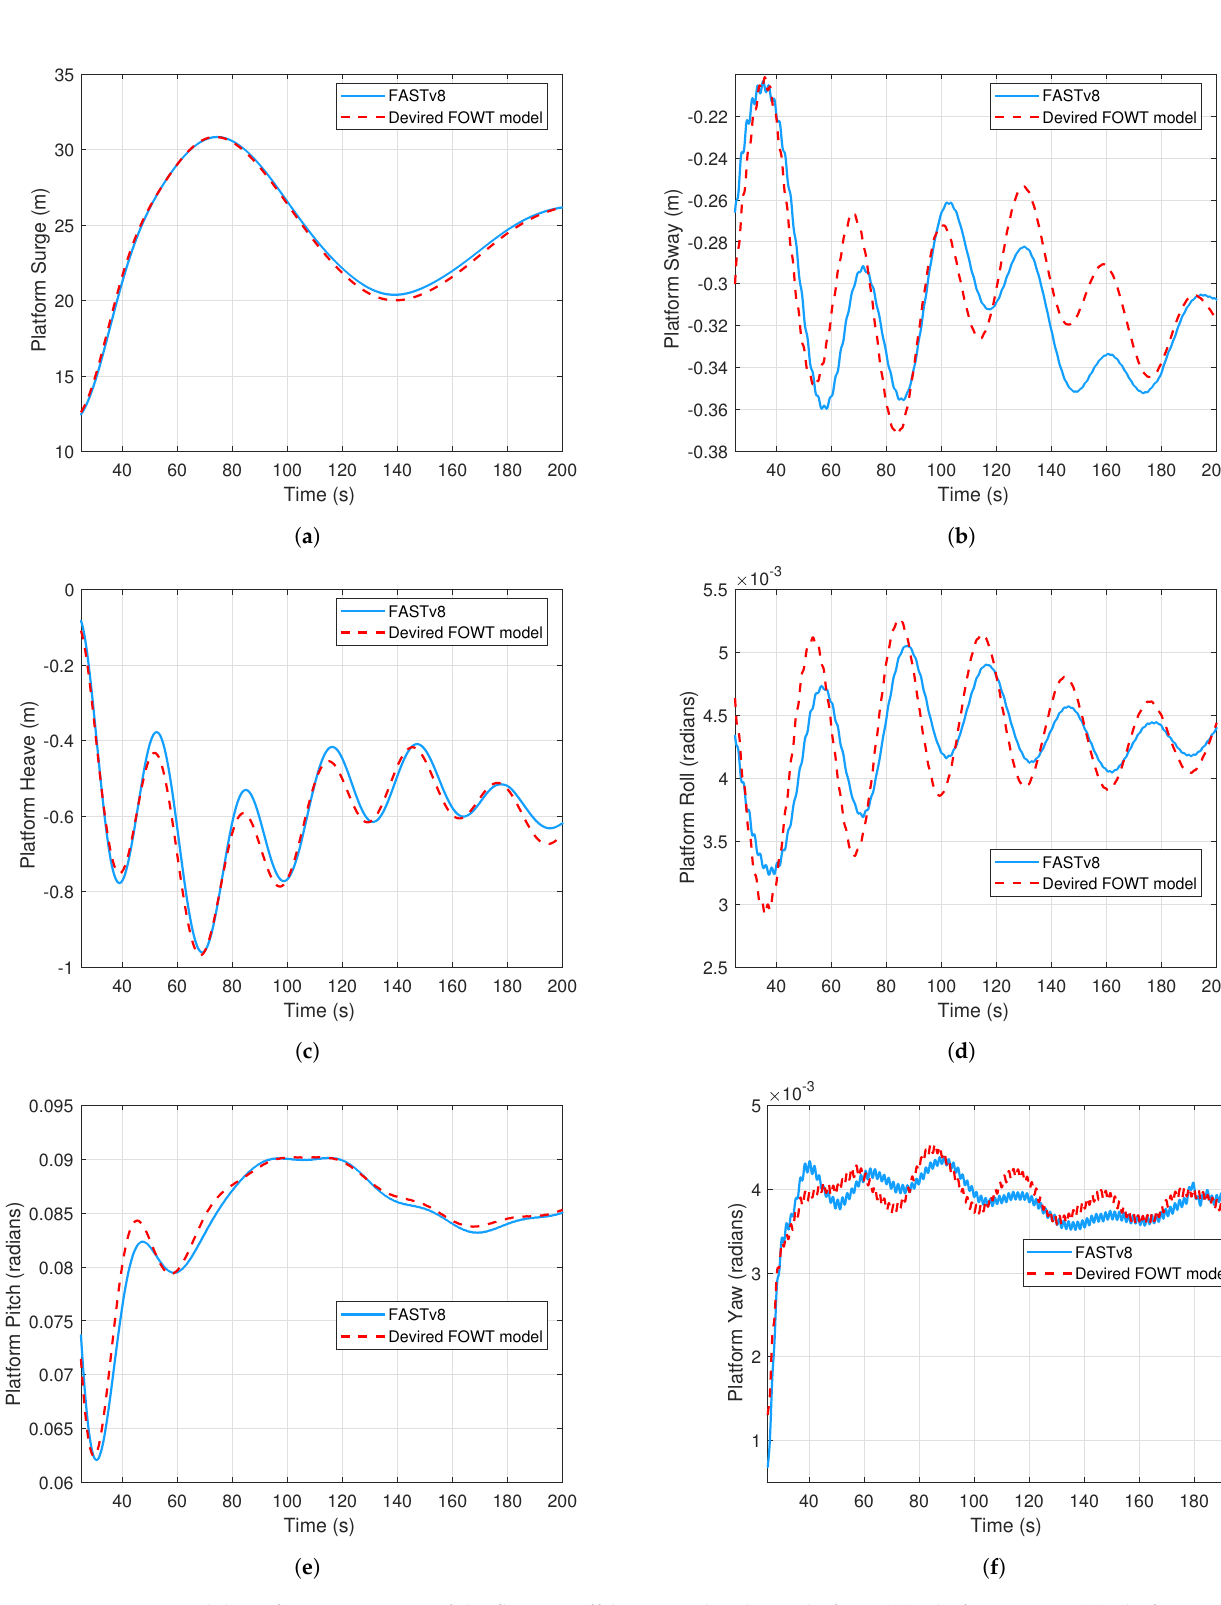
Figure A1. Model verification: motion of the floating offshore wind turbine platform. ( a ) Platform surge; ( b ) Platform sway; ( c ) Platform heave; ( d ) Platform roll; ( e ) Platform pitch; ( f ) Platform